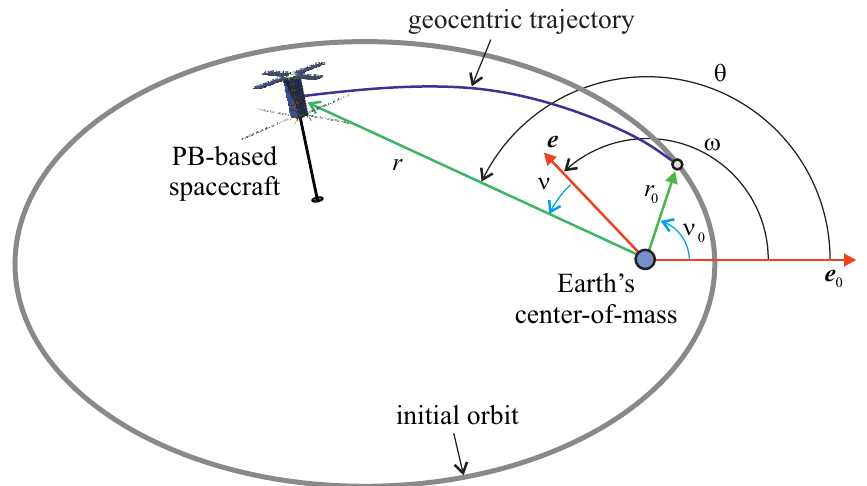
Figure 3. Reference frame and PB-based spacecraft orbital